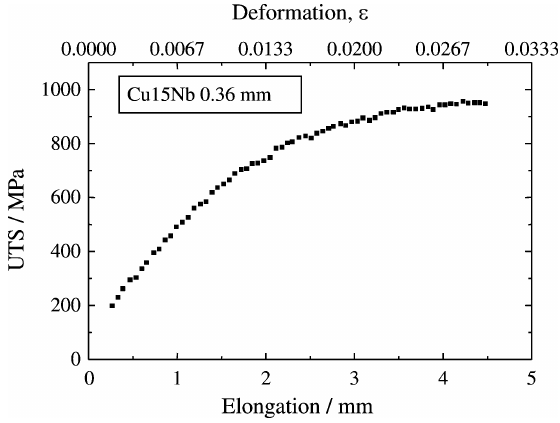
Figure 6. Stress versus strain curve for the Cu 15 vol.% Nb composite. Wire diameter of φ = 0.36